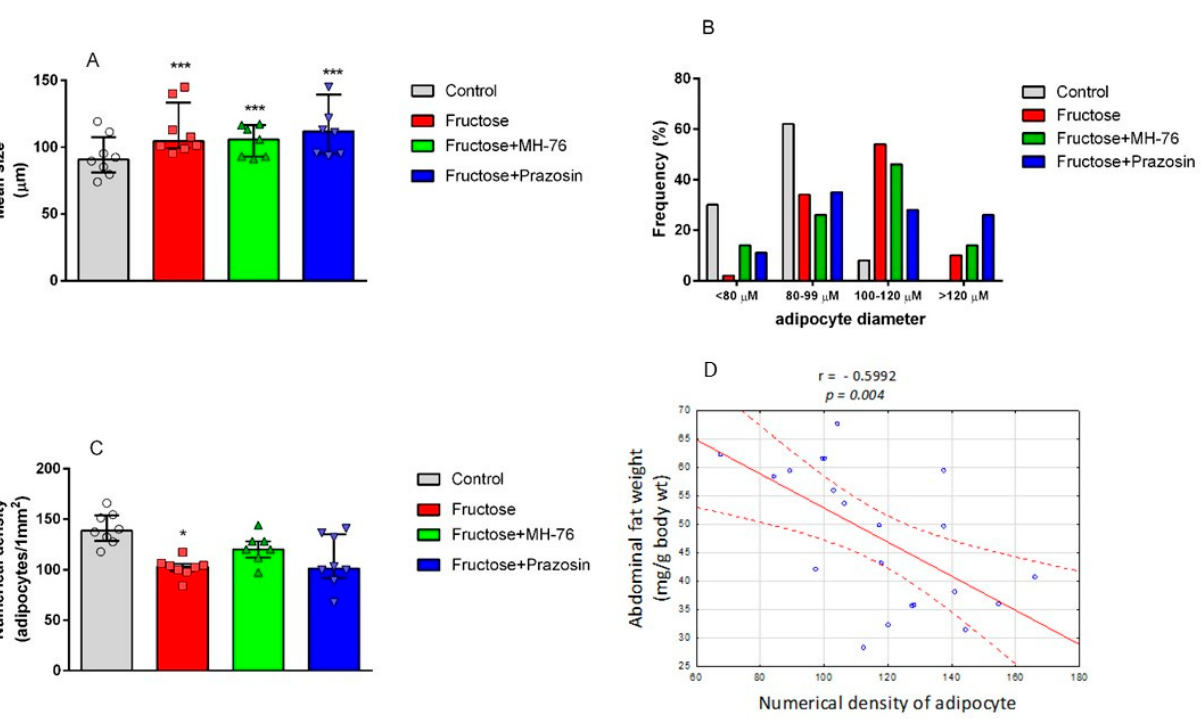
Figure 4. Mean size of adipocytes determined by microscopic measurement of cell diameter ( A ), profile of the distribution of adipocyte size ( B ), and numerical density of adipocytes ( C ) from abdominal adipose tissue of the Control, Fructose, Fructose + MH-76, and Fructose + Prazosin rats. Data are expressed as median + interquartile range (IQR), ( A , C ), * p < 0.05 and *** p < 0.001 versus Control, (Kruskal–Wallis test by ranks, post hoc Dunn test). Significant negative correlation between abdominal fat weight (mg/g body wt) and numerical density of adipocytes (Pearson correlation), ( D